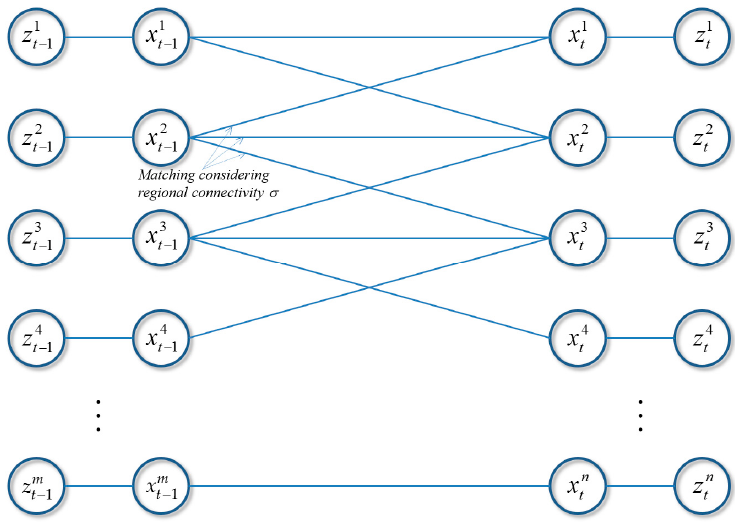
Figure 2. Graph of a CRF between frame t − 1 and frame t.